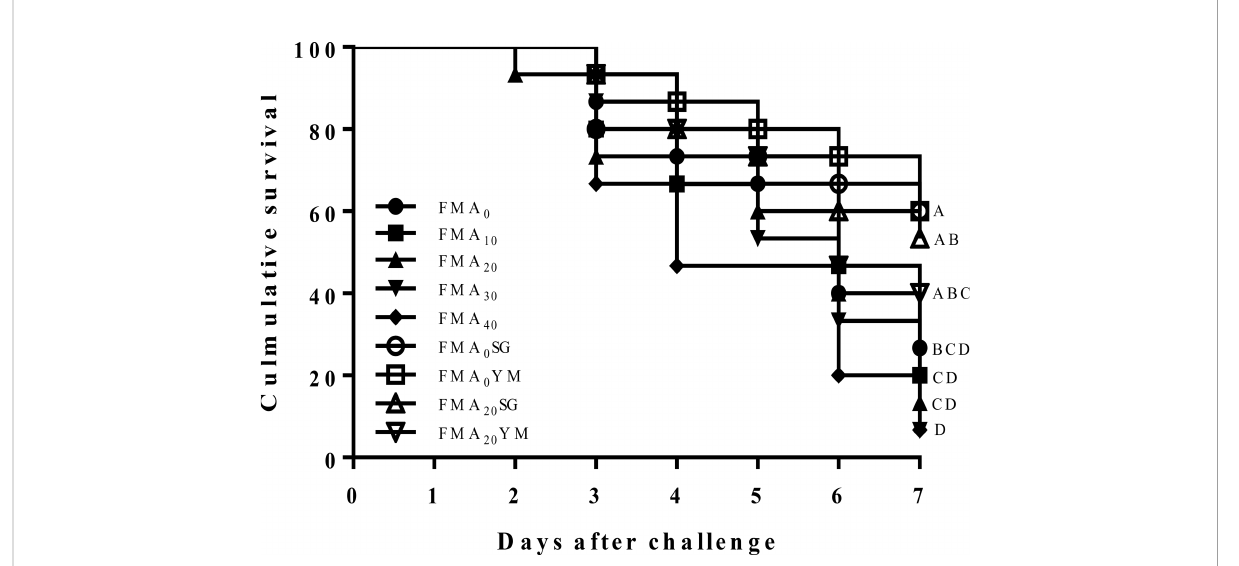
FIGURE 1 Cumulative survival rate after challenged with V. anguillarum for 7 days in Japanese eel fed with the nine experimental diets after 8